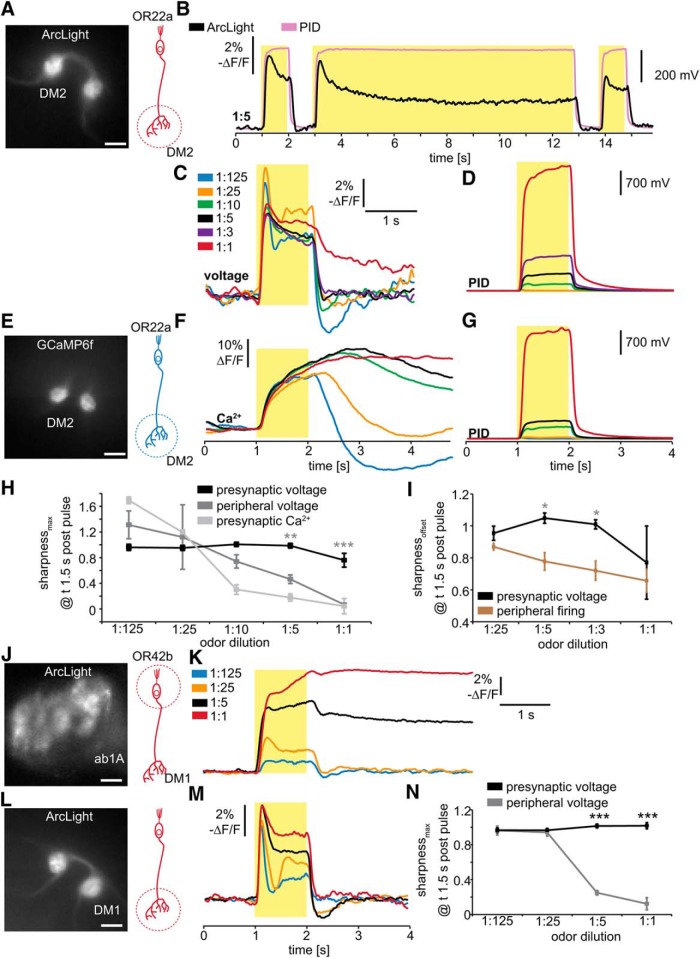
Optical electrophysiology of presynaptic axon terminals of OSNs indicates temporal contrast enhancement. A, Fluorescent image of the antennal lobe of a fly expressing ArcLight in OR22a-expressing OSNs. Scale bars, 10 µm. The axon terminals of these neurons innervate the DM2 glomerulus. B, Single-trial optical recording of presynaptic membrane potential in DM2 in response to pulses of 1:5 Eb, measured with the PID at the fly. Yellow boxes indicate odor pulse duration. C, Mean presynaptic electrical responses (n = 5–11) in DM2 to 1 s Eb pulses of the indicated gas-phase dilutions. D, Mean PID signals for the odor pulses in C, measured at the fly. E, Fluorescent image of the antennal lobe of a fly expressing GCaMP6F in OR22a-expressing OSNs. Scale bar, 10 µm. F, Mean presynaptic Ca2+ responses (n = 4–5) in DM2 to 1 s Eb pulses of the gas-phase dilutions indicated in C. G, Mean PID signals for the odor pulses in F, measured at the fly. H, Sharpness coefficient based on peak amplitude [(ΔF/F)Max − (ΔF/F)1.5 s postpulse]/(ΔF/F)Max of OSN voltage and Ca2+ responses in the antenna and AL. Sharpness of antennal voltage and presynaptic Ca2+ responses decreases with increasing odor concentration, while presynaptic voltage responses remain sharp, indicating the existence of a mechanism for temporal contrast enhancement of presynaptic electrical responses. Mean ± SEM; n = 4 for antennal voltage, n = 4-5 for presynaptic Ca2+, and n = 5-11 for presynaptic voltage. Statistical analysis: two-way ANOVA with Bonferroni post hoc test (antennal voltage as control); **p < 0.01; ***p < 0.001. I, Sharpness coefficient based on neuronal activity at odor offset [(ΔF/F or Hz)offset − (ΔF/F or Hz)1.5 s postpulse]/(ΔF/F or Hz)offset comparing presynaptic voltage and peripheral firing rate of OSNs also indicates presynaptic contrast enhancement. Statistical analysis: two-way ANOVA with Bonferroni post hoc test; *p < 0.05. J, Fluorescent image of the antenna of a fly expressing ArcLight in OR42b-expressing OSNs. Scale bars, 10 µm. K, Mean peripheral electrical responses (n = 4) in OR42b-expressing neurons to 1 s Eb pulses of the indicated gas-phase dilutions. L, Fluorescent image of the antennal lobe of a fly expressing ArcLight in OR42b-expressing OSNs. Scale bar, 10 µm. The axon terminals of these neurons innervate the DM1 glomerulus. M, Mean presynaptic electrical responses (n = 6) in DM1 to 1 s Eb pulses of the indicated gas-phase dilutions. N, Sharpness coefficient of peripheral voltage is reduced at high odor concentrations (1:5, 1:1), while presynaptic voltage responses remain sharp. Statistical analysis: two-way ANOVA with Bonferroni post hoc test, ***p < 0.001.